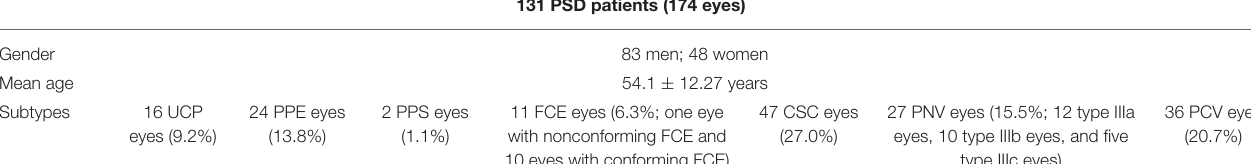
TABLE 1 | Demographic information.